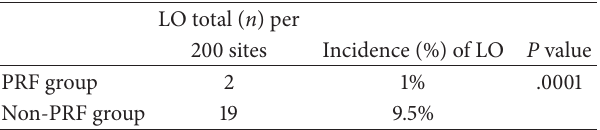
Table 3: Statistical